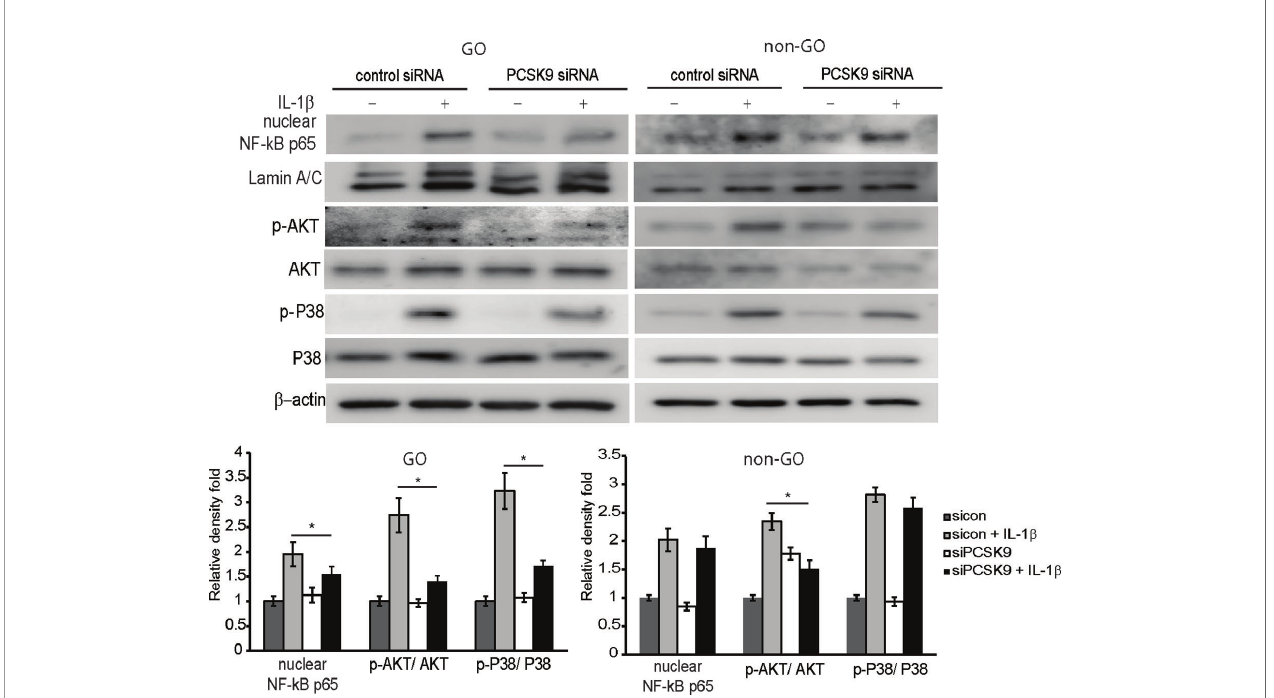
FIGURE 4 | Effect of silencing proprotein convertase subtilisin/kexin type 9 (PCSK9) on the activation of signal molecules by interleukin-1 b (IL-1 b ) treatment. Con fl uent orbital fi broblasts obtained from Graves ’ orbitopathy (GO) patients (n=3) were treated with or without 10 ng/ml of IL-1 b after transfection with control siRNA or PCSK9 siRNA (50 nM, 24 h). Treatment with IL-1 b (10 ng/ml, 60 min) resulted in an increase in the levels of nuclear NF- k B p65 and phosphorylated forms of Akt and p38. The treatment with PCSK9 siRNA in GO cells signi fi cantly blunted the increases in the transcription factors. However, in fi broblasts from non-GO subjects (n=3), the PCSK9 inhibition only suppressed the phosphorylated Akt. Representative gel images are shown. Data in the columns indicate the mean density ratio ± SD of the bands obtained from the GO patients, normalized to the level of b -actin in the same sample (* p < 0.05 between sicon + IL-1 b and siPCSK9 + IL-1 b